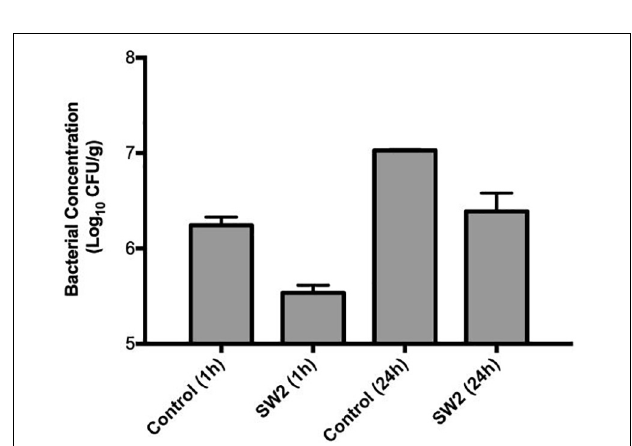
FIGURE 5 | Bacterial survival in a sterile sand model after treatment with sterile buffer (control) or phage Sw2 at 10 9 PFU/mL. Bacterial loads were measured 1 and 24 h after treatment. The detection limit of this assay is 2 log 10